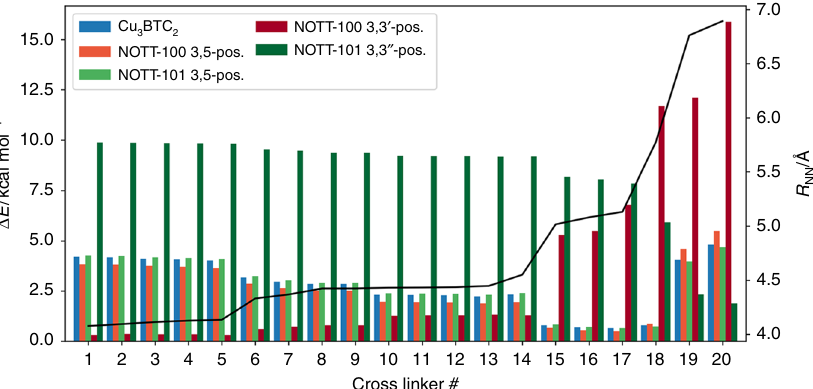
Fig. 8 Summary of the RetroFit results. The energy penalties Δ E (bars) of all CL@MOF materials studied in this work are compared. The R NN distance of the CLs is visualized by the black line. Due to the anisotropy of the linker for the NOTT systems, two different positions, here referred to as 3,5 and 3,3 ′ (or 3,3 ” ) are possible and have been tested. For bridging two OMSs in a MOF, distinct R NN windows that lead to low Δ E can be identi fi ed. Cu 3 BTC 2 , NOTT-100 (3,5-position) and NOTT-101 (3,5-position) have very similar Δ E values with an optimum at R NN ≈ 5.1 Å. NOTT-100 (3,3 ′ -position) shows the best fi t for low R NN values, whereas NOTT-101 (3,3 ” -position) shows the opposite applying RetroFit to NOTT-100 and NOTT-101 are shown in Fig. 8 and compared to Cu 3 BTC 2 . In the 3,3 ′ -position of NOTT- 100, the short R CuCu distance of 7.601 Å in combination with the obtuse angle of γ = 145.65° requires molecules with very short R NN distances (see Supplementary Fig. 16). The isoreticular